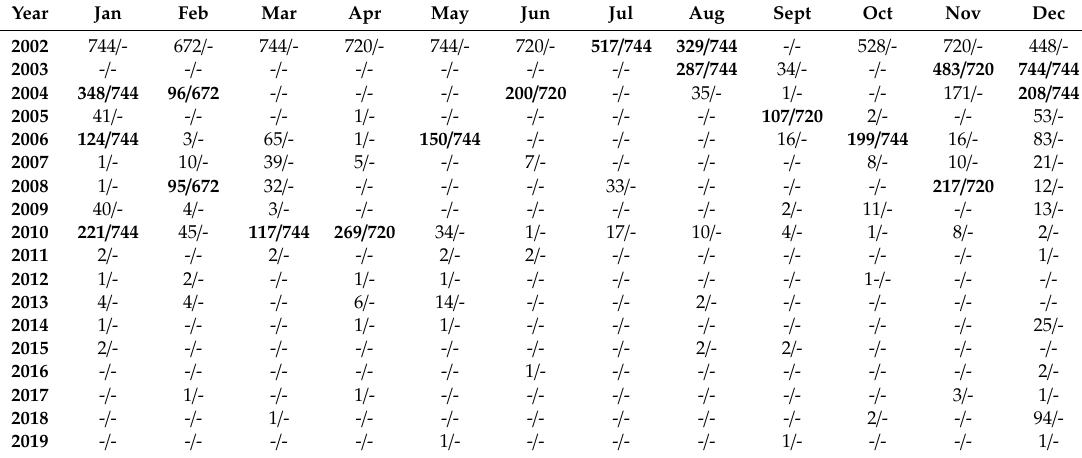
Table 5. Gaps in the hourly data measured by the SIAS station, before and after the filling procedure.